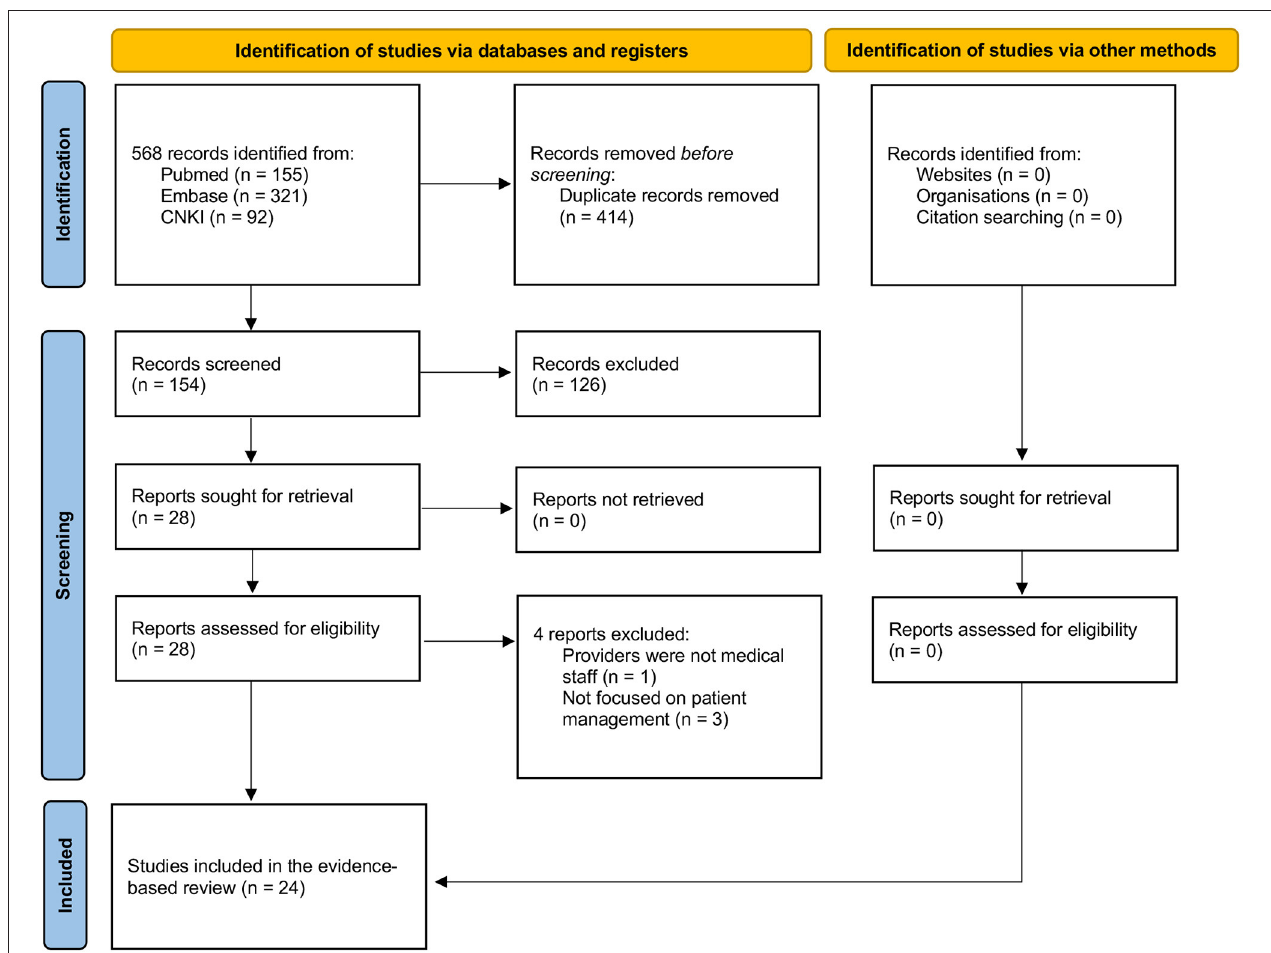
FIGURE 2 | Flow diagram of study selection for the evidence-based